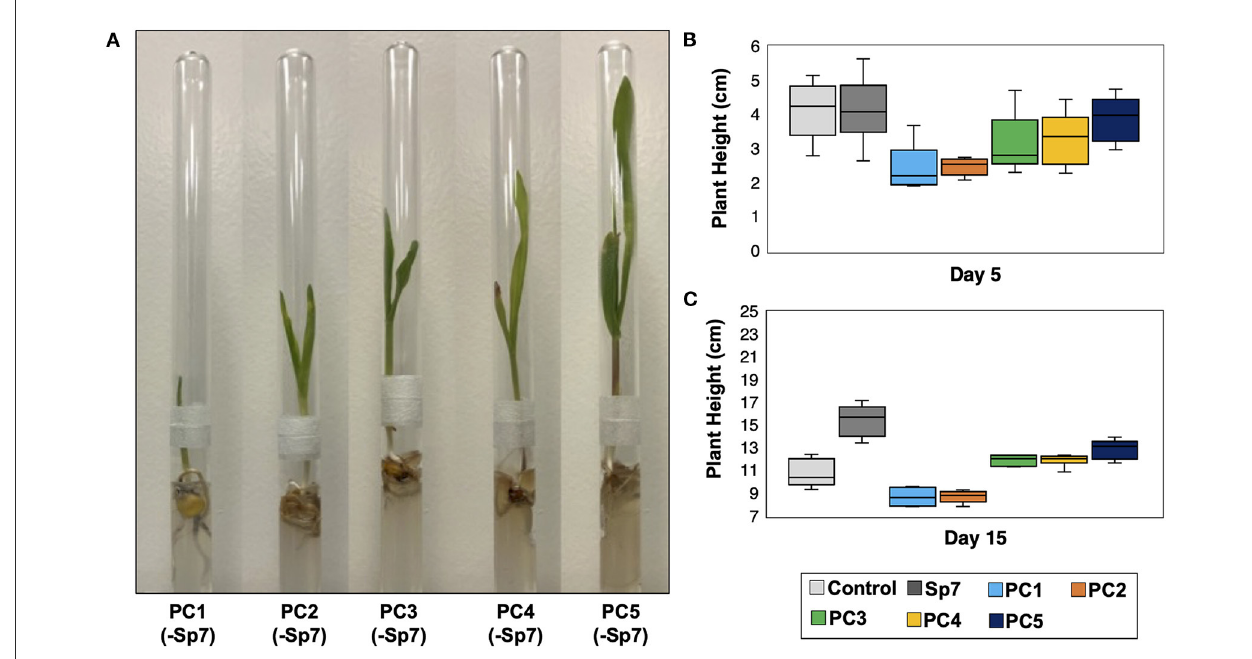
FIGURE6 Growth of axenic maize seedlings after innoculation with each promoter consortium (PC1-PC5) but without Sp7. (A) Plant growth in growth chambers after 15 days. Comparision of plant heights for each consortium at (B) day 5 and (C) day 15 with sterile seedlings (control) and with seedlings inoculated with Sp7 only. n = 6 replicate trials.